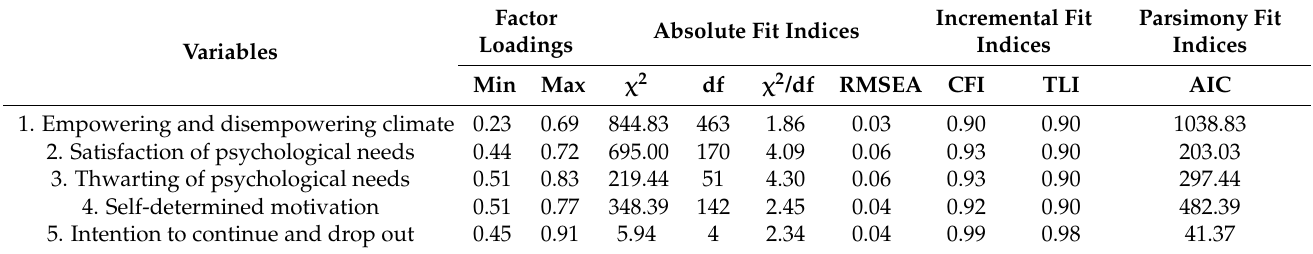
Table 1. Confirmatory factor analysis of the instruments used to measure the study variables.